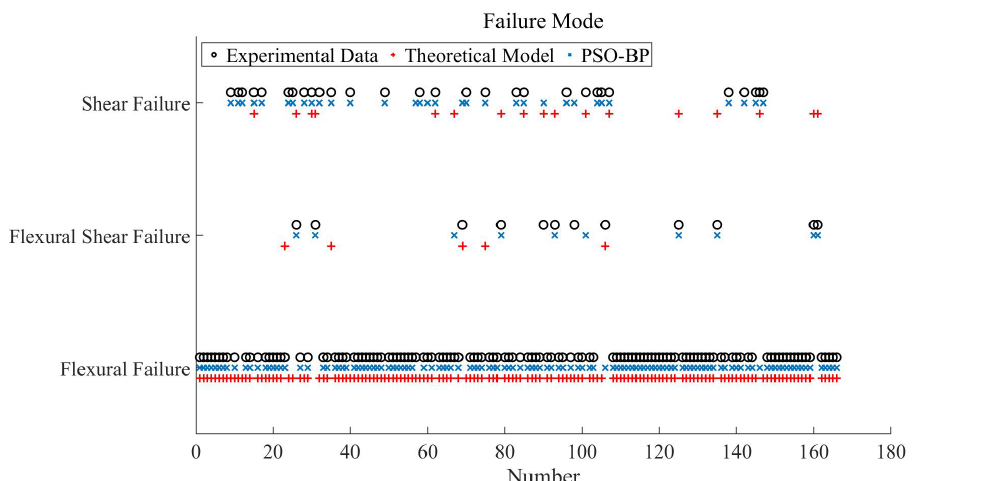
Figure 9. Comparison of PSO-BP with Theoretical Model for Yield Displacement.